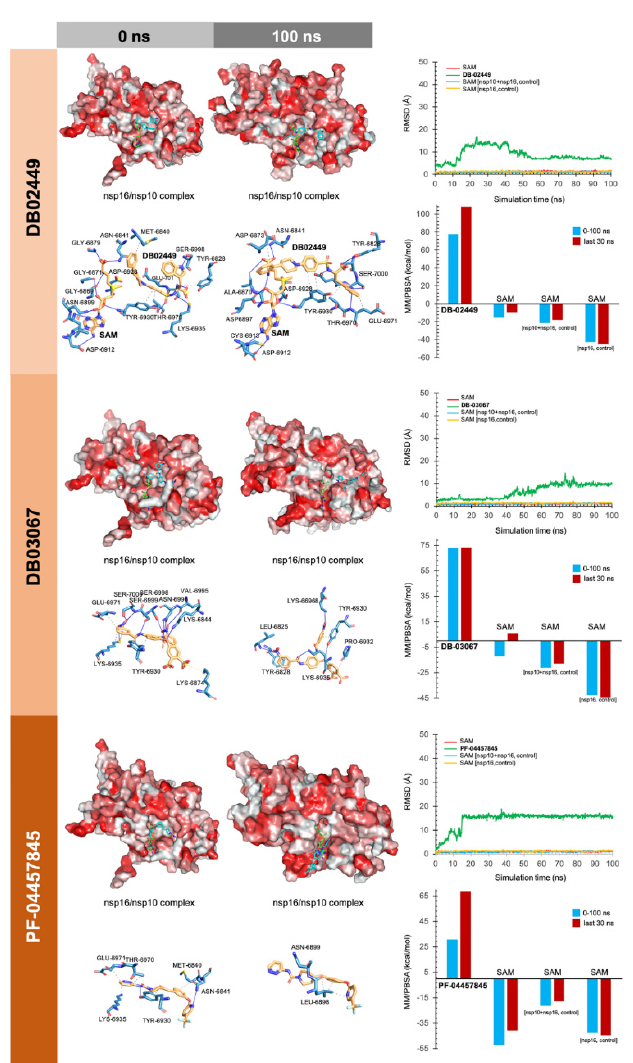
Figure 5. Incorporation models of predicted RNA-binding-groove-targeting drugs in SARS-CoV-2 2 ′ -O-MTAse. The best poses of predicted candidates coupled to the RNA activating surface of nsp16 before (0 ns) and after (100 ns) the molecular dynamics (MD) simulation are shown. The protein has been represented as a function of the hydrophobicity of its surface amino acids and the Na + and Cl - ions have been eliminated to facilitate visualization. Each inset shows the detailed interactions of each drug candidate docked to the RNA-binding groove of nsp16, indicating the participating amino acids involved in the interaction and the type of interaction (hydrogen bonds, hydrophilic interactions, salt bridges, Π -stacking, etc). The root mean square deviation (RMSD, Å) of each drug’s heavy atoms over the simulation time, measured after superposing the protein on its reference structure, is shown. In the context of the MD presented here, the RMSD incorporates traces of SAM alone and in two additional control simulations (i.e., nsp16 / nsp10 complex and nsp16 alone).